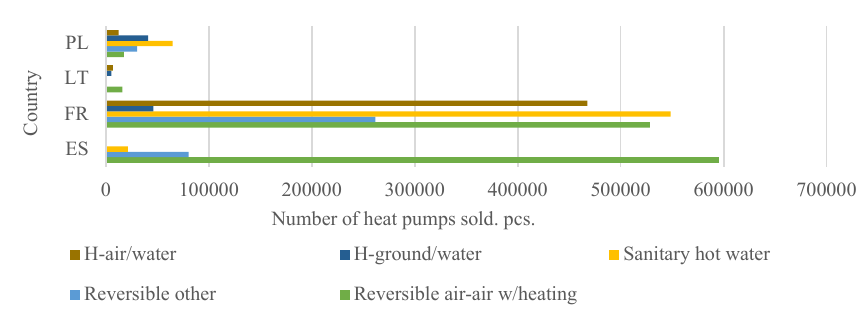
Fig. 4. The number of heat pump sold in 2009–2018 by type, for selected countries.